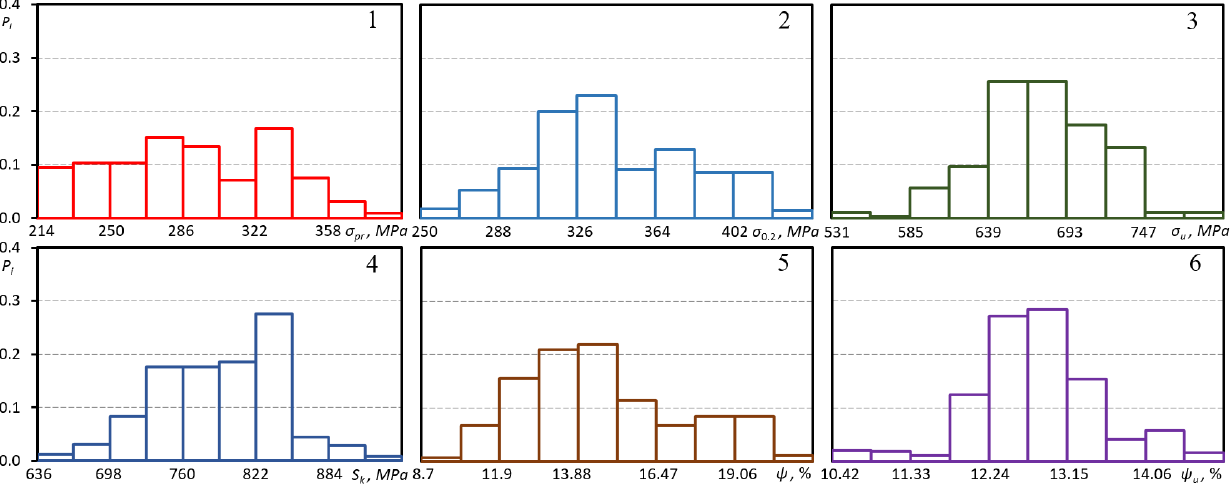
Figure 4. Histograms of mechanical properties of aluminium alloy D16T1 (1 — σ pr ; 2 — σ 0.2 ; 3 — σ u ; 4 — S k ; 5 — ψ ; and 6 — ψ u ).